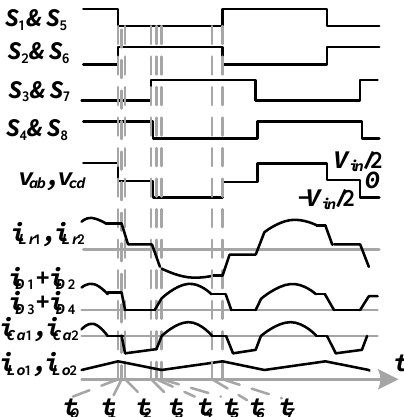
Figure 3. Pulse width modulation (PWM) waveforms of the presented converter.